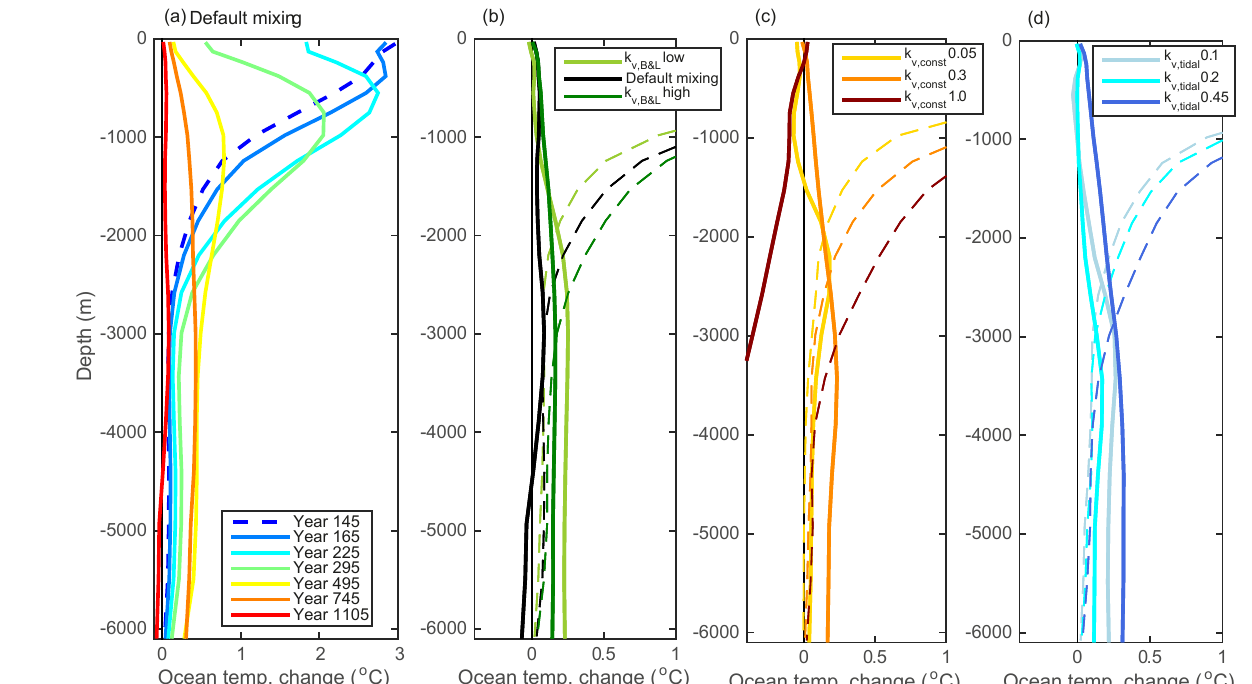
Figure 2. Depth profile of change in ocean temperature relative to year 0 for the model version with the default mixing setting for various points in time (a) . Depth profile of change in ocean temperature relative to year 0 for model versions with different ocean mixing settings at year 140 (dashed curves, year of peak forcing) and year 1100 (solid curves) for Bryan and Lewis mixing scheme (b) , constant mixing scheme (c) , and tidal mixing scheme (d)